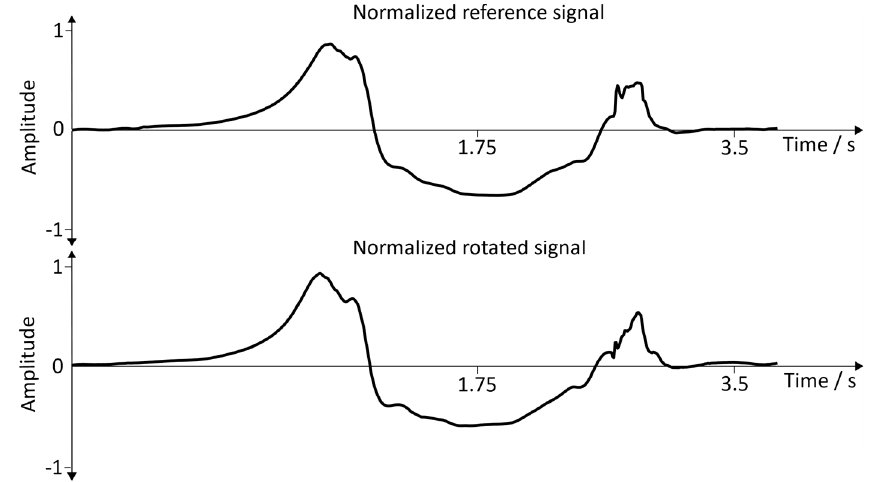
Figure 20. Normalized reference signal and normalized rotated signal. Position of the sensor: dorsum of the foot.